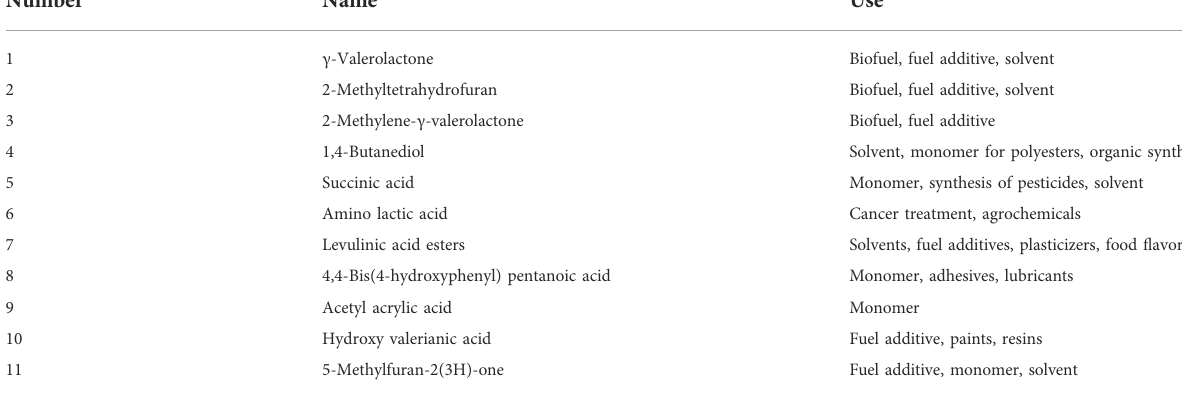
TABLE 8 Uses and applications of bio-derivatives from levulinic